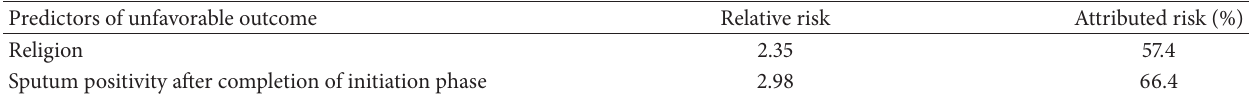
Table 4: Relative risk and attributed risk for significant predictors of unfavorable